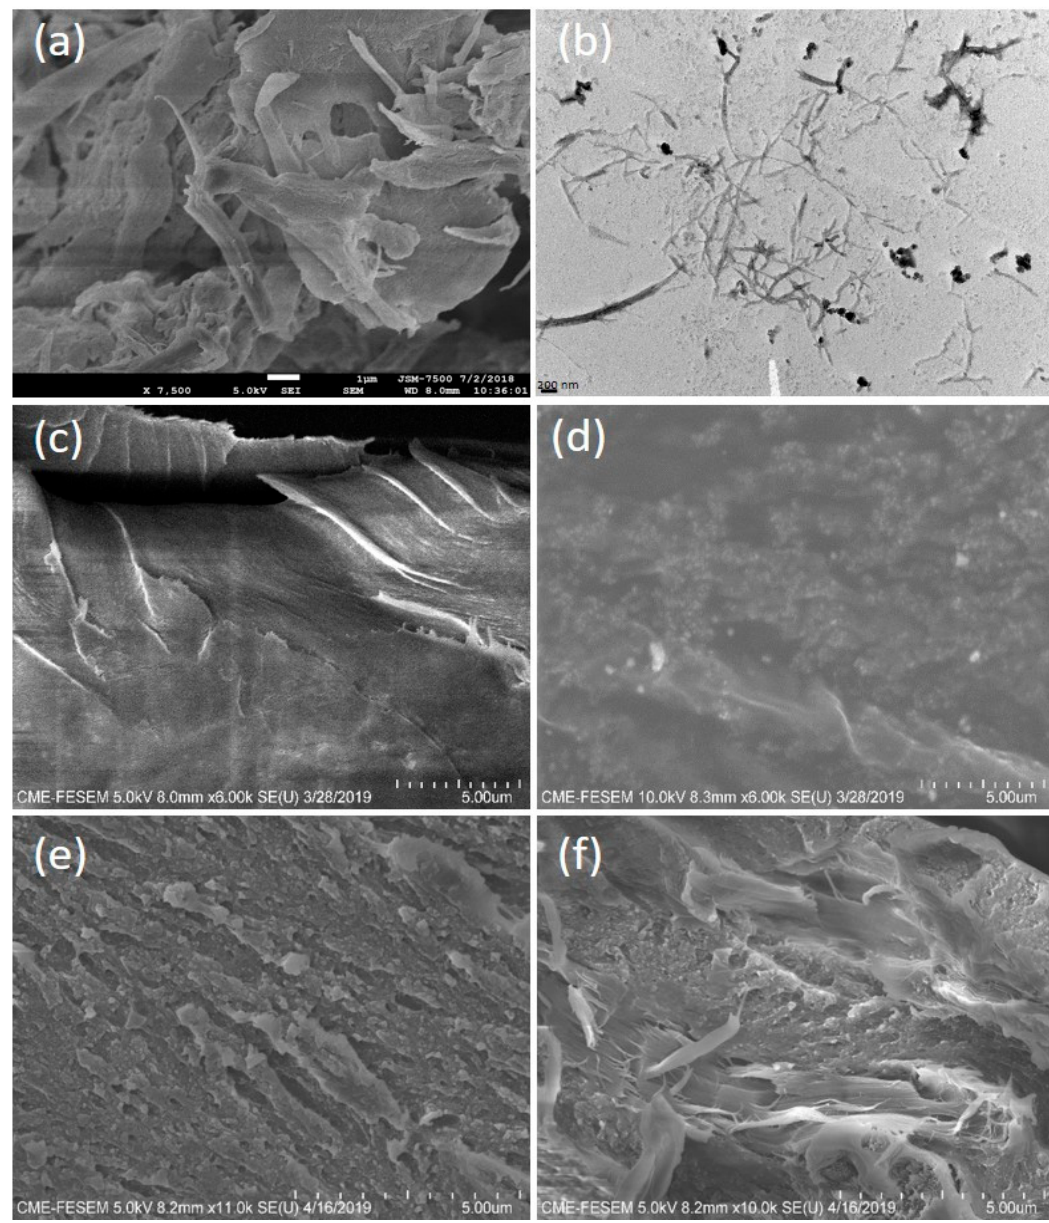
Figure 4. ( a ) Field emission scanning electron microscopy (FESEM) of CNC in powder form, ( b ) TEM image of water dispersed CNC, ( c ) FESEM cross-section image of CS0 films, ( d ) FESEM cross section image of CS4 film, ( e ) FESEM cross-section image of fractured CS0 films, and ( f ) FESEM cross-section image of fractured CS4 film.